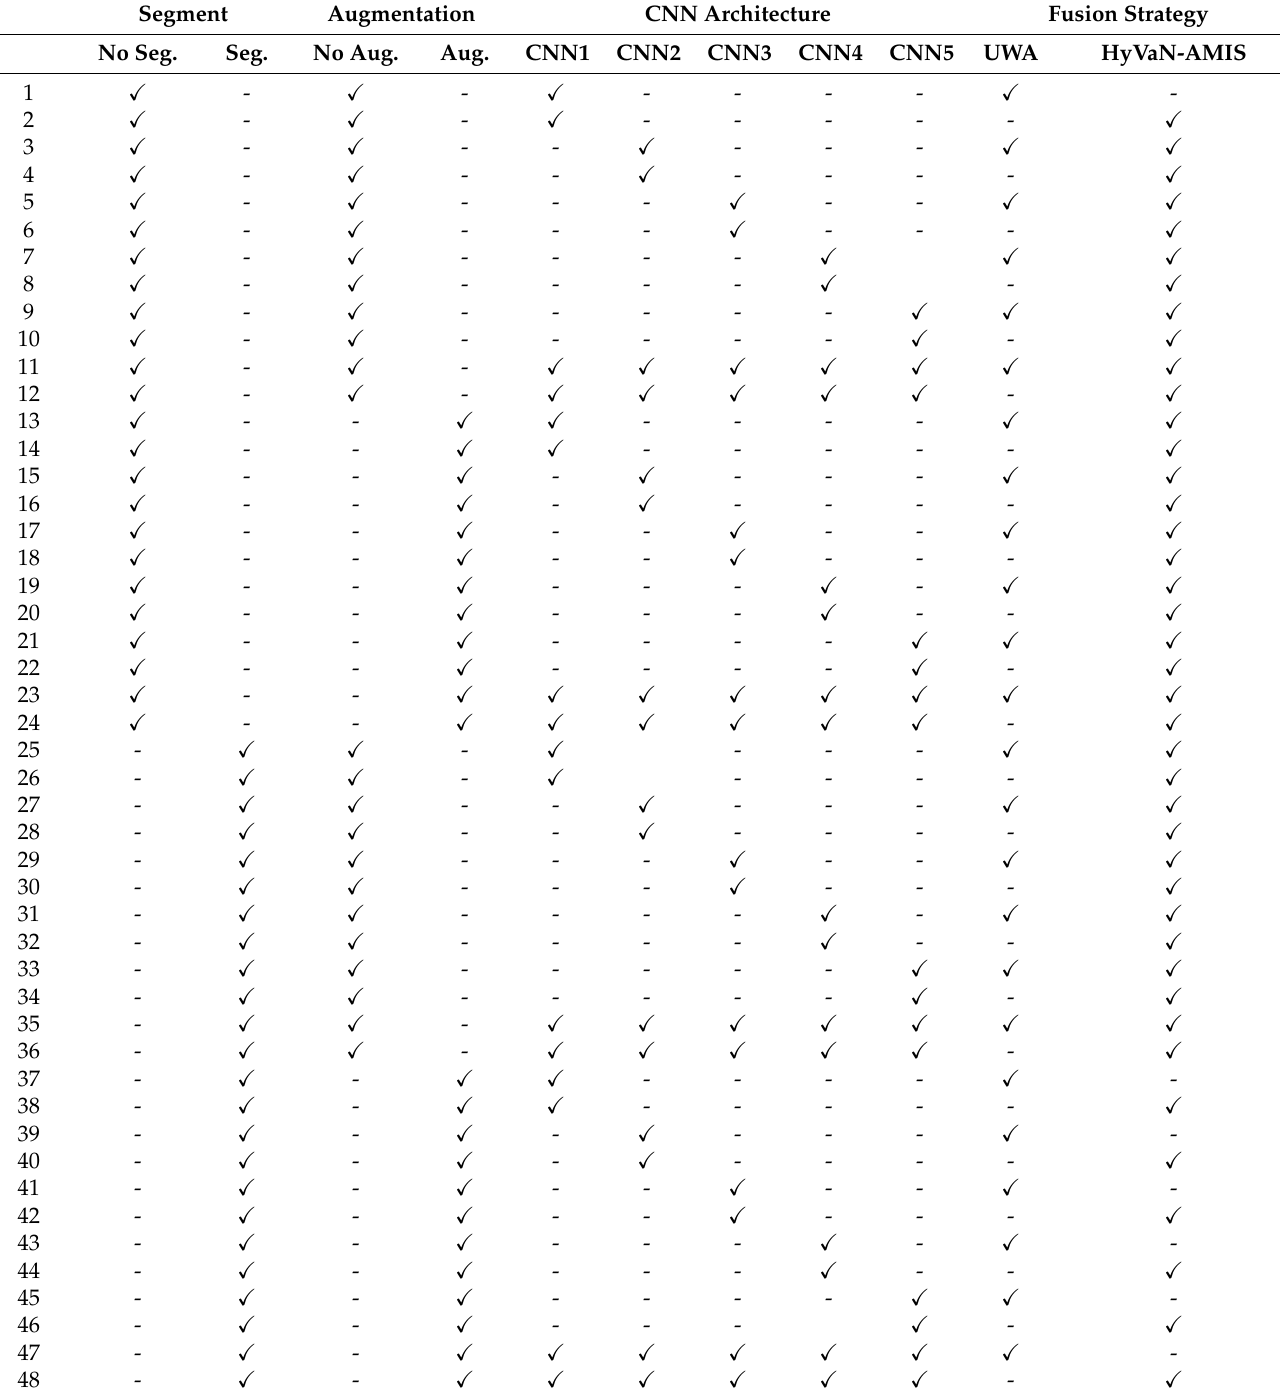
Table 5. Design of an experiment to determine the viability of the proposed